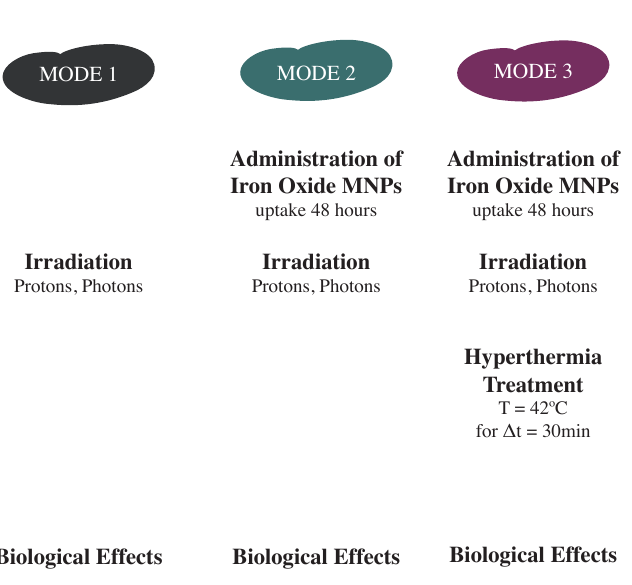
Figure 1. Description of the three different treatment modes used during the experiments: simple irradiation ( Mode 1 ), iron oxide magnetic nanoparticles (MNPs) administration and irradiation ( Mode 2 ) and MNPs administration plus irradiation and subsequent hyperthermia ( Mode 3